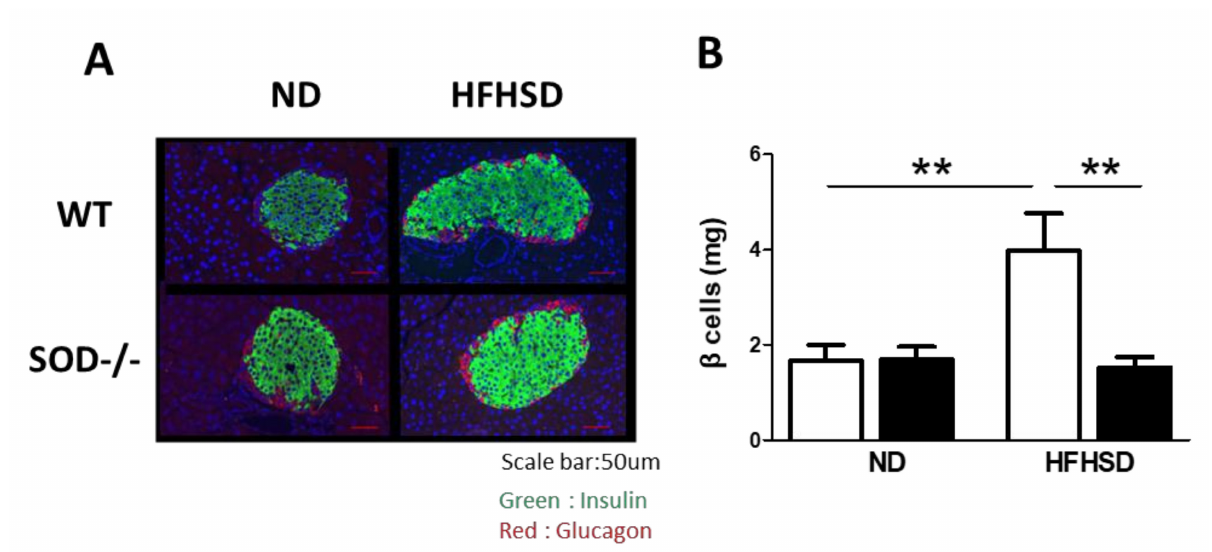
Figure 3. Weight of pancreatic β -cells. ( A ). Immunofluorescence staining of the pancreas with insulin (green) and glucagon (red) antibodies. The scale bar is 50 µ m. ( B ). Quantitative analysis of pancreatic beta cell weights. (WT on ND; n = 8, SOD1 − / − on ND; n = 8, WT on HFHSD; n = 8, SOD1 − / − on HFHSD; n = 8). Error bars represent SEM. ** p < 0.01. WT: wild-type mice, SOD1 − / − : SOD1 deficient mice, ND: normal diet, HFHSD: high-fat/high-sucrose